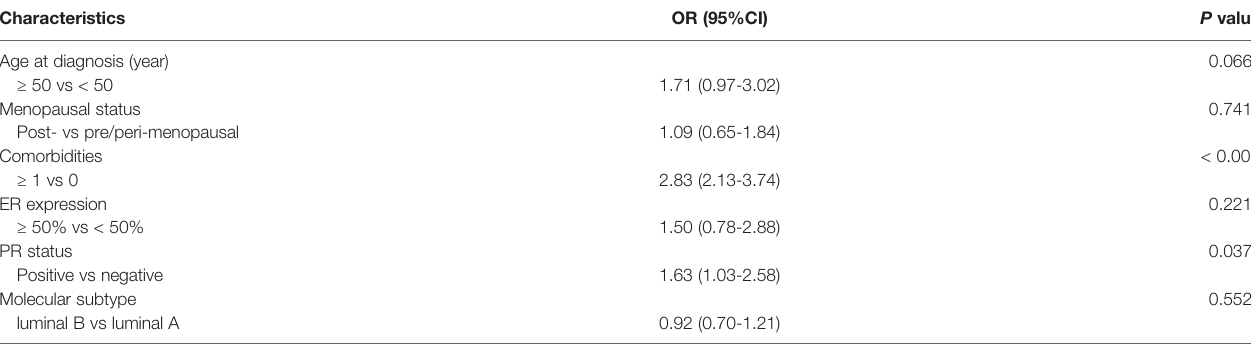
TABLE 3 | Multivariate analysis of factors associated with obesity.